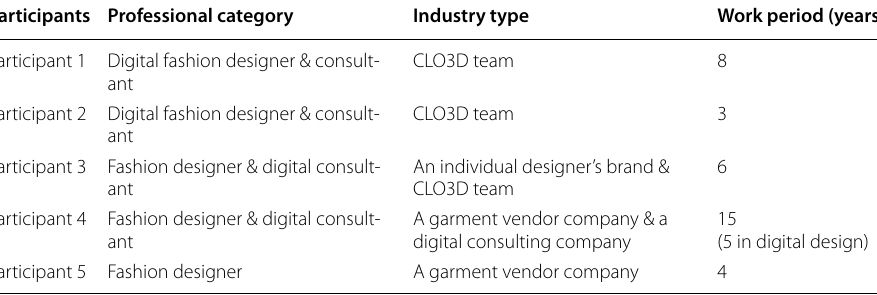
Table 2 Brief description of the focus group interview